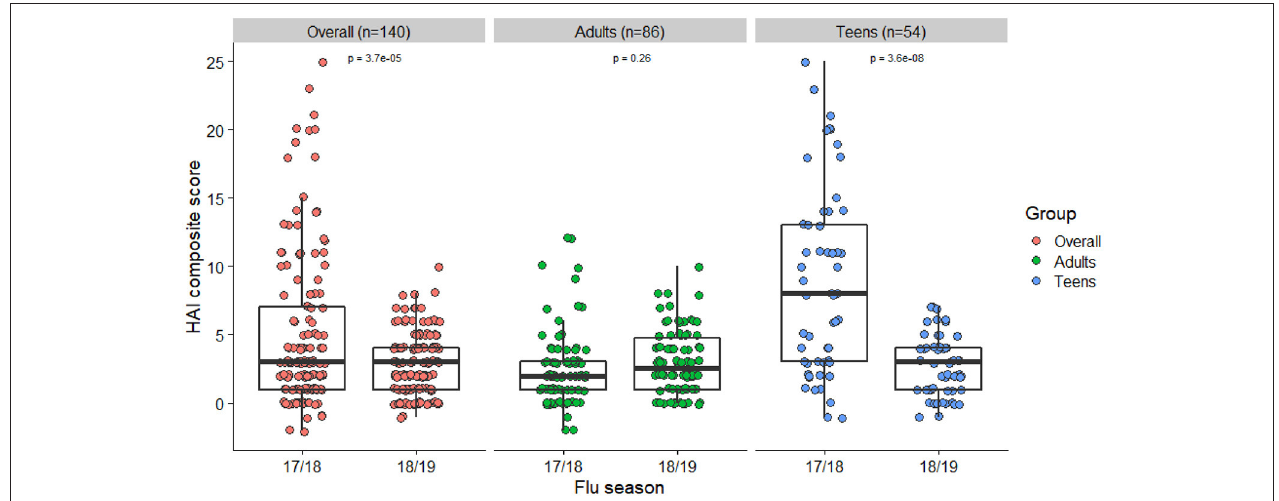
FIGURE 1 | HAI composite scores among different age groups in 17/18 and 18/19 ( N = 140).